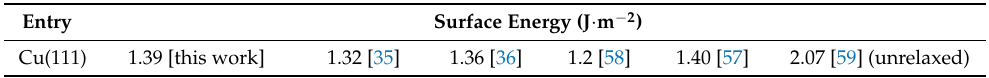
Table 3. Calculated surface energy of Cu (111).